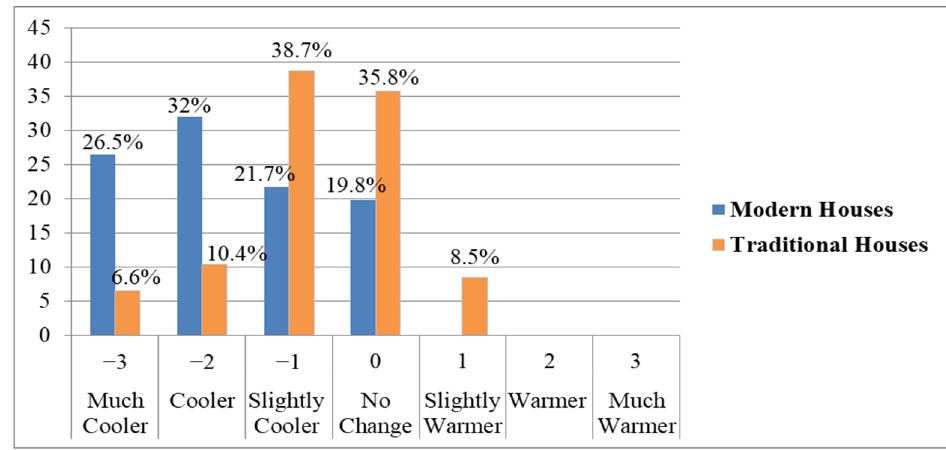
Figure 20. Thermal preference scale for condominium and traditional houses .